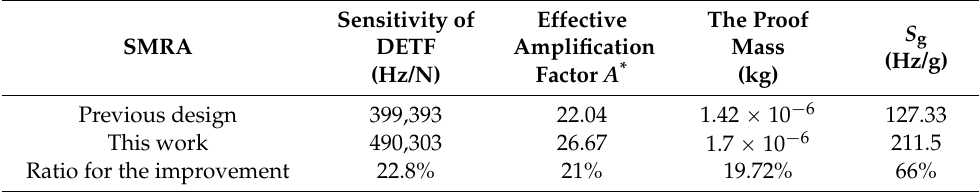
Table 3. The sensitivity improvement between the two